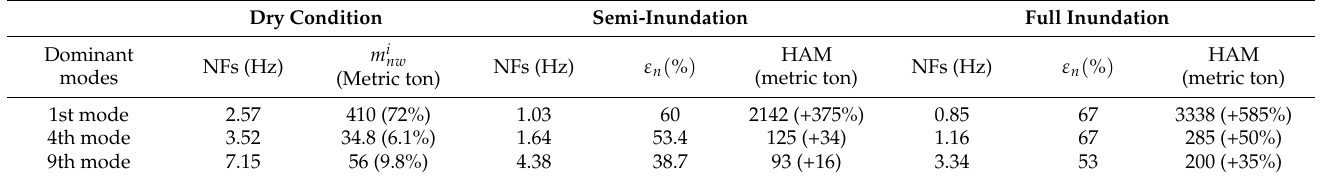
Table 3. Experimental and numerical NFs, effective modal mass, and HAM for the full-scale